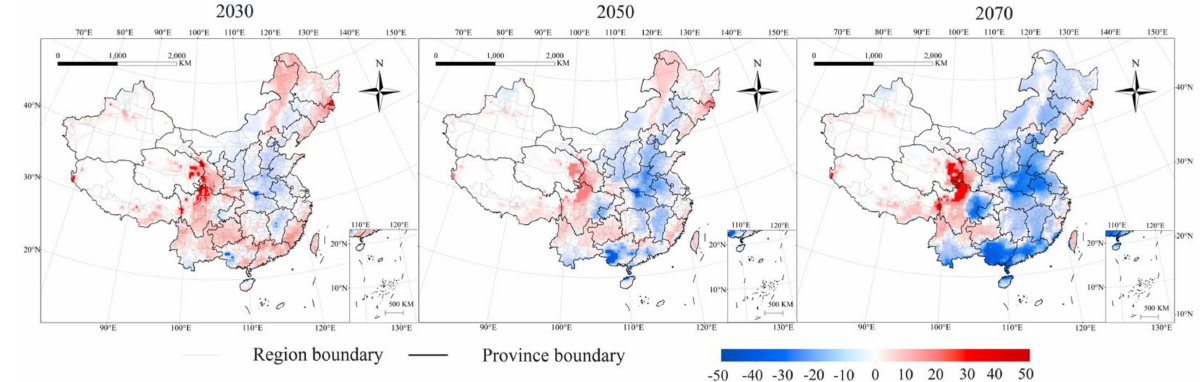
Figure 5. The change in the EI values on interpolation maps for P. interpunctella under current and future climate conditions. Red represents the increase in EI values and blue indicates the decrease in EI values. The color becomes darker as the difference in the EI value increases.